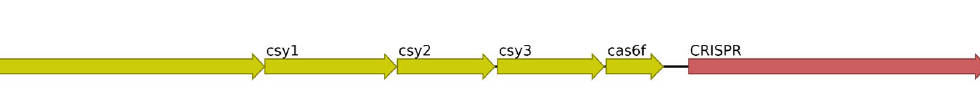
Figure 5. The type I-F CRISPR-Cas element found in some of the L. longbeachae isolates sequenced in this